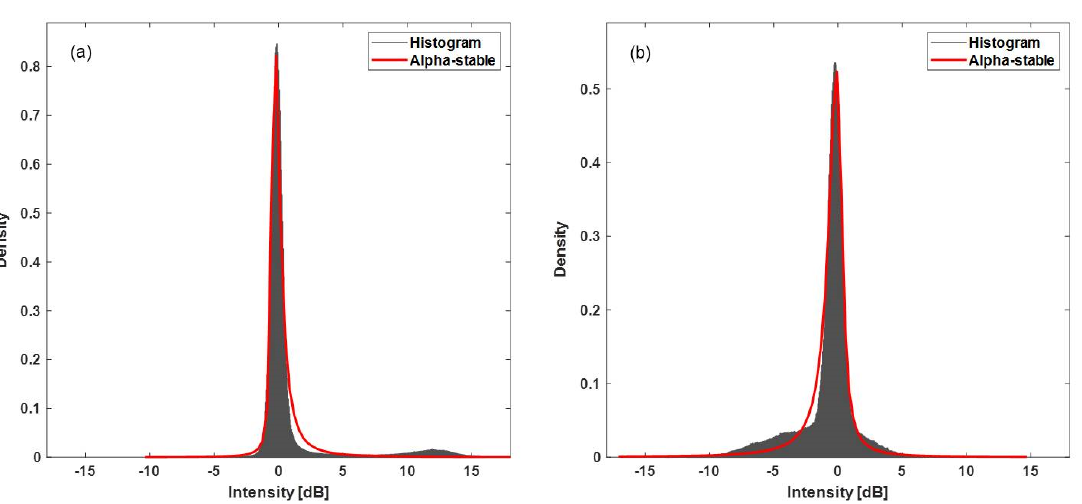
Figure 5. Histogram and α -stable distribution fitting for the di ff erence image di ff erence image between Figure 5 . Histogram and α -stable distribution fitting for the difference image difference image August 6 and July 13 at ( a ) Xe-Namnoy reservoir and ( b ) Hinlat between August 6 and July 13 at ( a ) Xe-Namnoy reservoir and ( b ) Hinlat area.